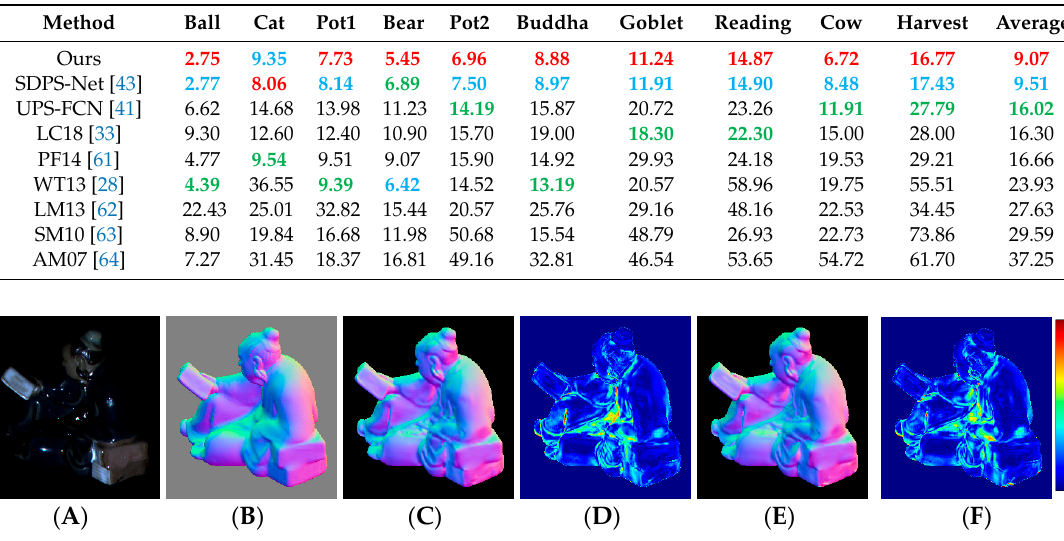
Figure 5. Visual quality comparisons on the Reading object in the DiLiGent benchmark for the uncalibrated photometric stereo: ( A ) one image among 96 input images; ( B ) ground-truth surface normal map; ( C ) surface normal map estimated with SDPS-Net; ( D ) angular error map for SDPS-Net; ( E ) surface normal map estimated with the proposed method; ( F ) angular error map for the proposed method.